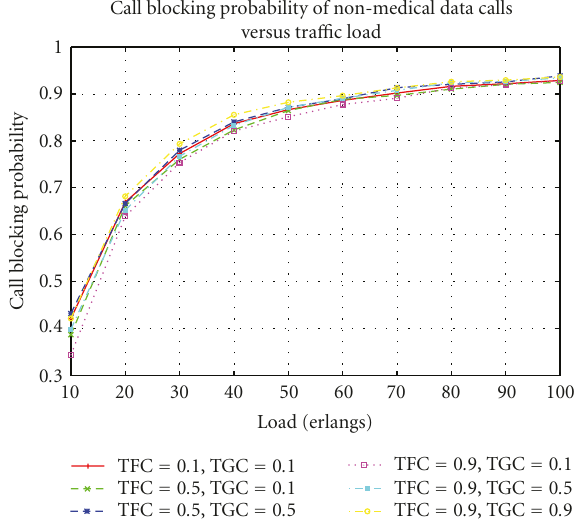
Figure 4: Call blocking probability of nonmedical calls versus traf- fic load.